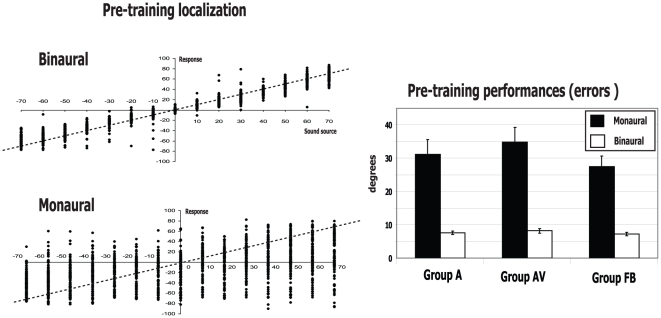
Performances of the subjects in the binaural and monaural conditions.On the left, the horizontal axis represents the azimuthal positions of loudspeakers, the vertical axis represents the azimuthal response of the subjects. On the right, the mean pre-training responses collapsed across the positions are shown for each group of subjects. The dashed line is the ideal performance curve in this case (e.g., the sound source at 60° corresponds to the response at 60°).